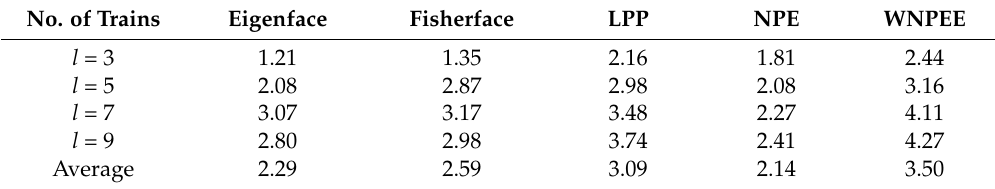
Table 2. Computation time on ORL face database under different trains for one run (time in